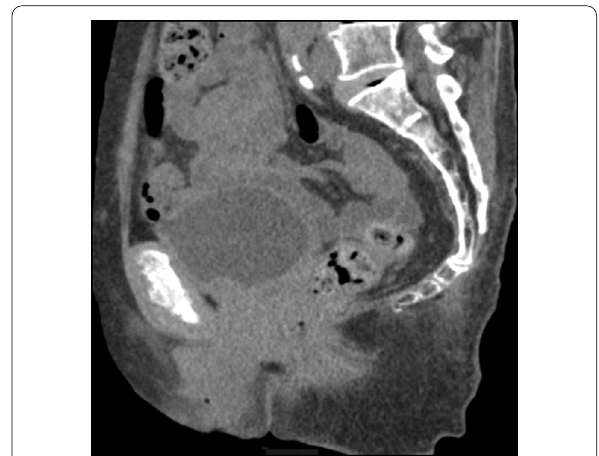
LVMR compared to the other procedures without mesh for the patient who has the risk of bowel injury when dis- secting adhesions caused by the previous surgery.